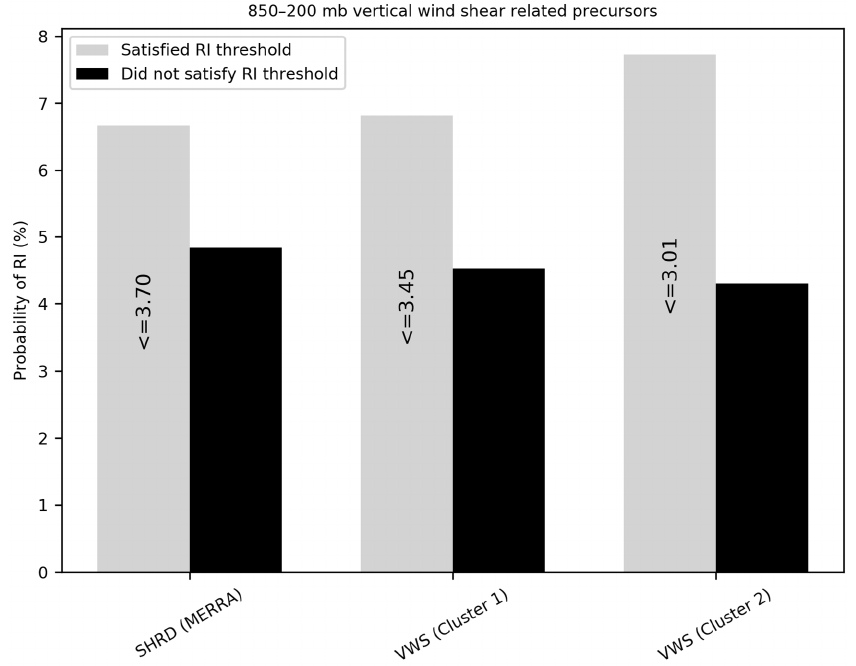
Figure 12. The probability of RI when the 850–200 hPa vertical wind shear related precursors were satisfied for the RI and non-RI samples. The RI thresholds for each of the predictors are also presented in m/s.